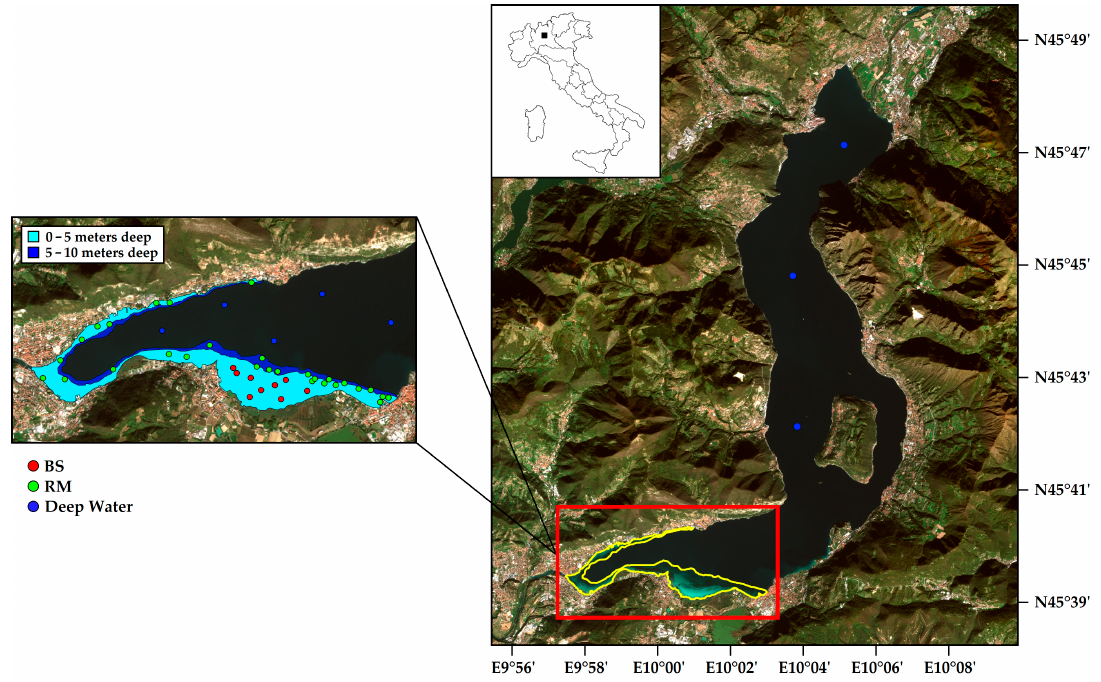
Figure 1. Lake Iseo as observed in a Sentinel-2 image (17 May 2017) displayed as true color: the red box delimits the southern part of the lake where the study area is located and highlighted in yellow (area with 0–10 m depth). The zoom area on the left depicts the 0–5 m deep (light blue) and 5–10 m deep (blue) regions within the study area. Red, green, and blue dots represent the location of field points for bare sediments (BS), rooted macrophytes (RM), and deep waters, respectively.